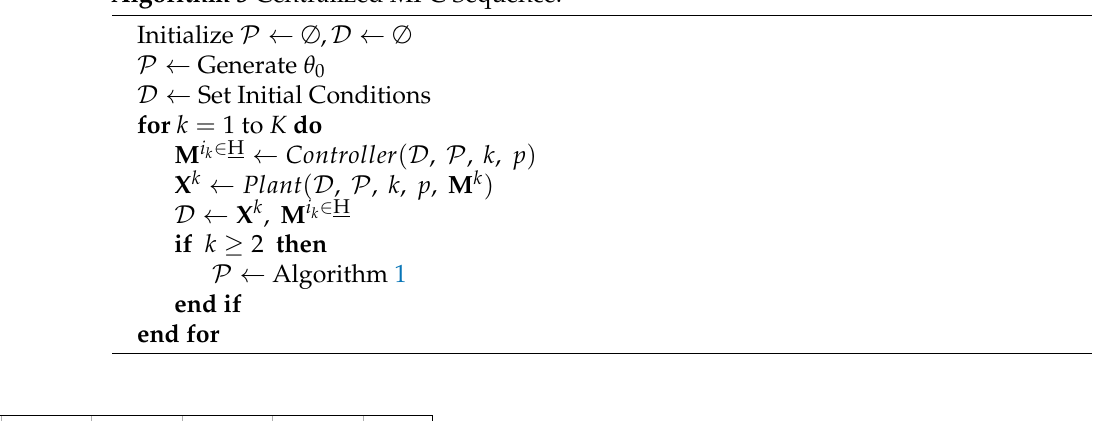
Algorithm 3 Centralized MPC Sequence.